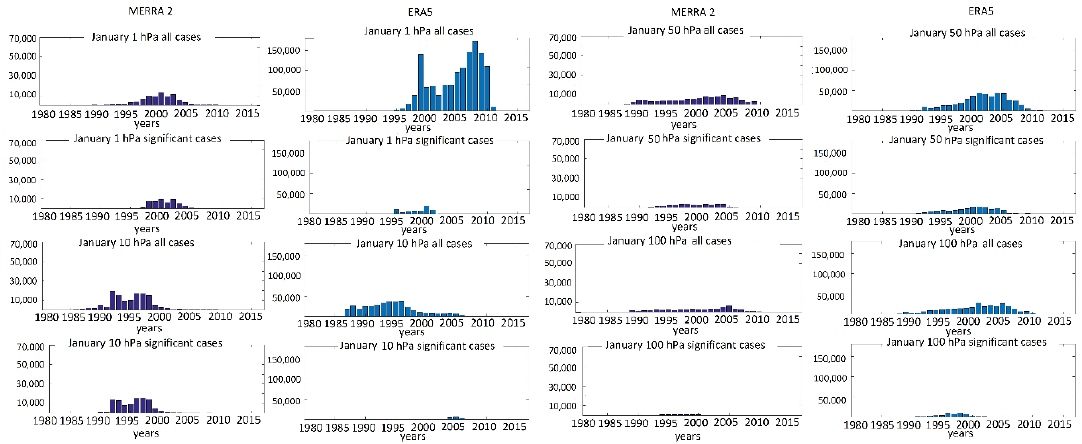
Figure 3. Geographical distribution of temperature jumps for MERRA2 and ERA5 at different pressure levels (1, 10, 50, and 100 hPa) for January. Significant cases mean the application of the variance condition. Red means grid point with identified jump.